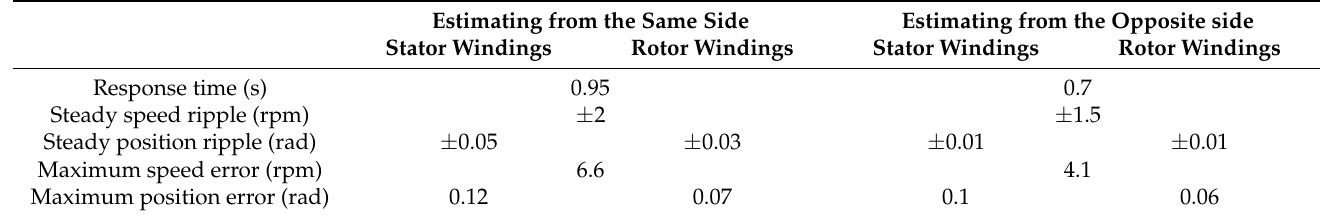
Table 4. Comparison of two estimating